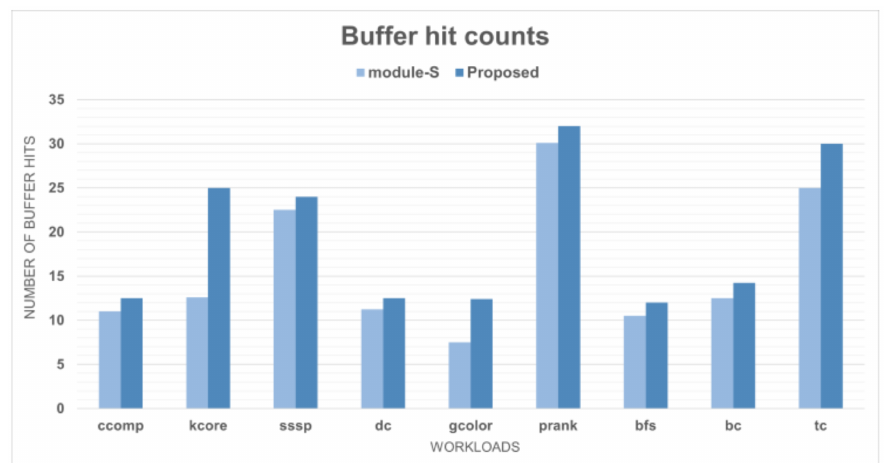
Figure 14. Buffer hit count of graph